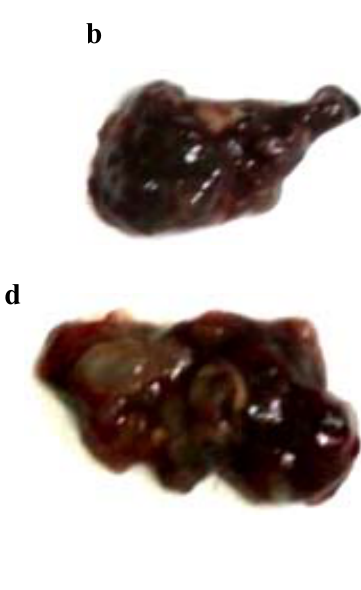
Figure 4. Efficacy of P-60 against tumor growth in C57BL/6